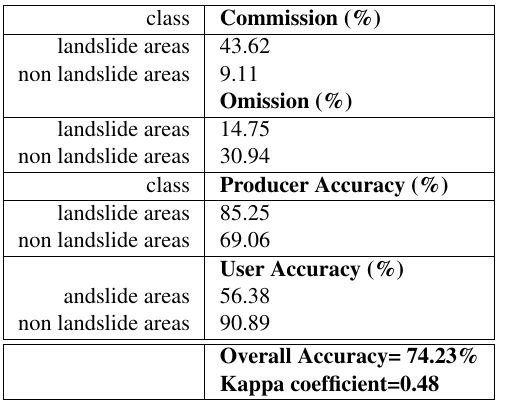
Table 3: Confusion Matrix of SVM classification using full